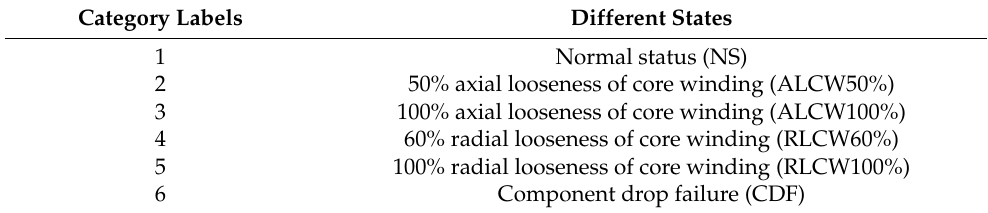
Figure 6. 10 kV HVSR experimental platform and fault simulation. Table 1. Typical 10 kV HVSR faults .